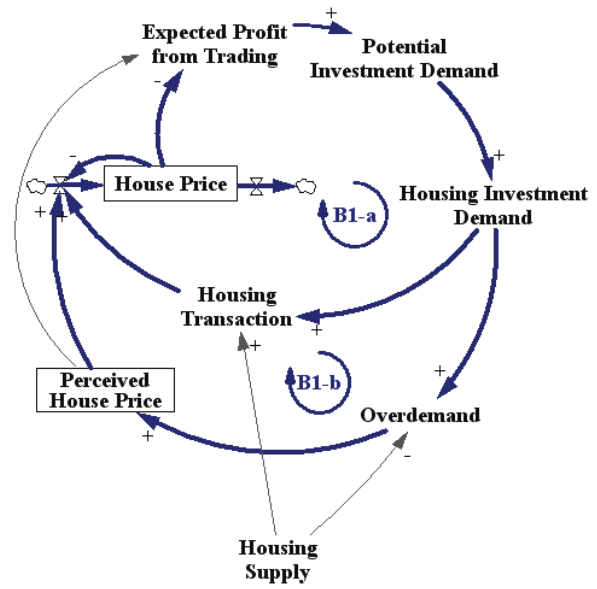
figure 4. Housing investment demand and house price